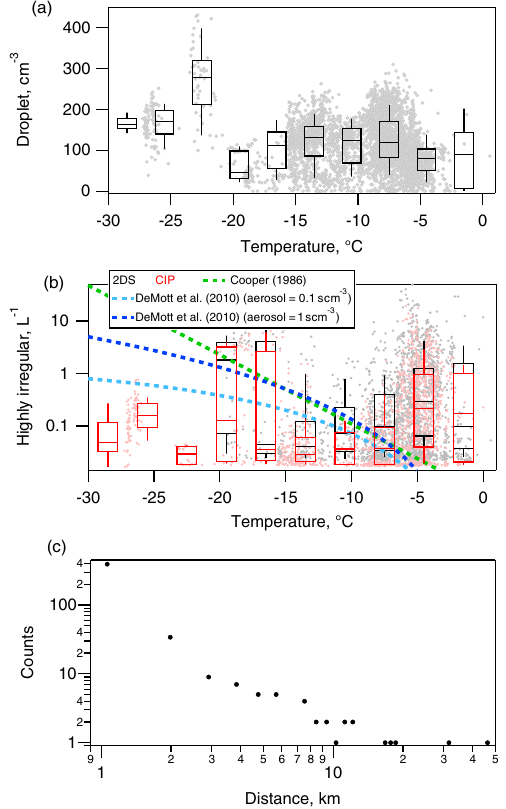
Figure 4. Box-and-whisker plots summarising in-cloud measure- ments (averaged over 10s) as a function of temperature. Panel (a) shows the concentration of cloud droplets (cm − 3 ), measured by CAS, while (b) shows the concentration of ice particles measured by 2DS and CIP-25, based on those classified as highly irregular (see text for details). The concentrations of INPs predicted by the DeMott et al. (2010) parameterisation with high (1scm − 3 ) and low (0.1scm − 3 ) aerosol input are shown as dark and light blue lines, respectively, in panel (b) . The green line is the predicted ice parti- cle concentration according to the Cooper (1986) parameterisation. Panel (c) shows a frequency plot of the flight distance while contin- uously sampling